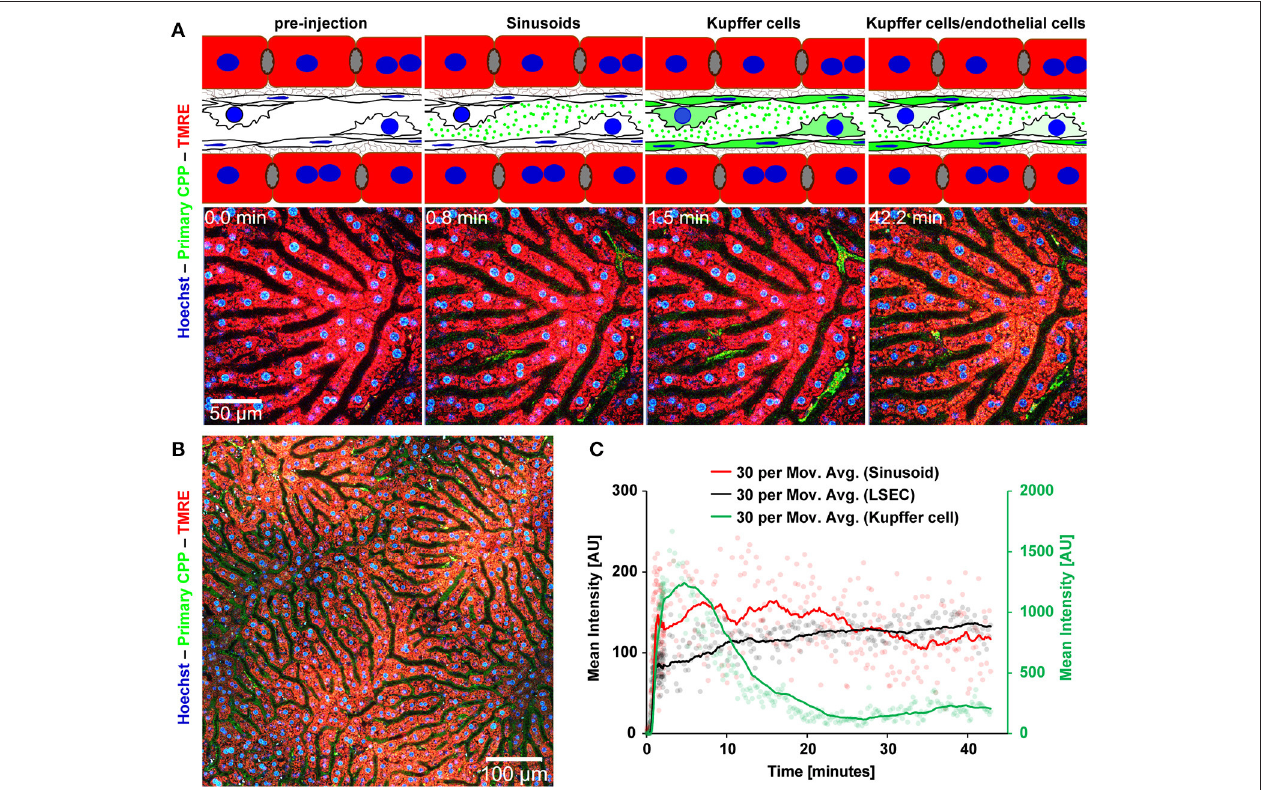
FIGURE 2 | Functional imaging of primary CPP clearance using 2-photon intravital microscopy. Mice received intravenous injections of primary CPP prepared with fluorescent fetuin-A, and the major clearance organ liver was continuously recorded for up to 1h. Fluorescent intensity was quantified in regions of interest (ROI) and clearance kinetics were calculated. Representative still micrographs with typical views of primary CPP clearing cells are shown. (A) Primary CPP clearance from sinusoids into liver sinusoidal endothelial cells (LSEC) occurred within 1min, and into Kupffer cells within 2min. Thereafter, primary CPP in Kupffer cells were rapidly degraded, shown by a fast decline of the signal after about 15min. (B) Overview showing a sector of a liver lobule. (C) Calculation of mean fluorescence intensity in the sinusoids, LSEC, and Kupffer cells determined by ROI